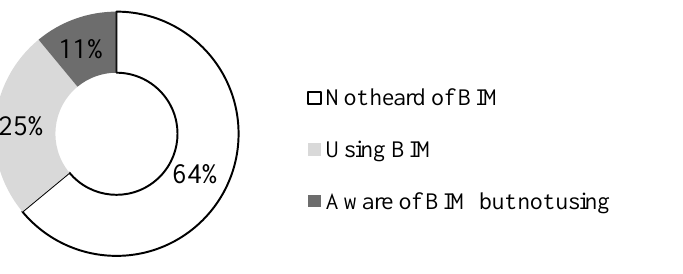
Figure 1. Building Information Modeling (BIM) adoption in the UK housing